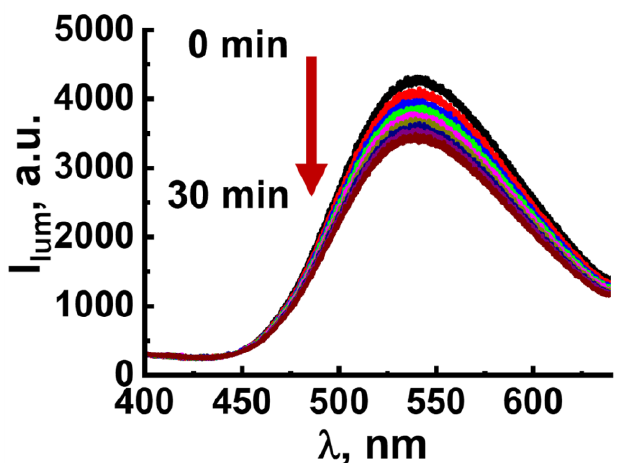
Figure 7. Luminescence spectra of F-127-Cu 2 I 2 L 3 colloids (C = 40  M, pH = 7.0) in the presence of ten-fold excess of GSH, recorded within 30 min after the sample preparation. ten-fold excess of GSH, recorded within 30 min after the sample